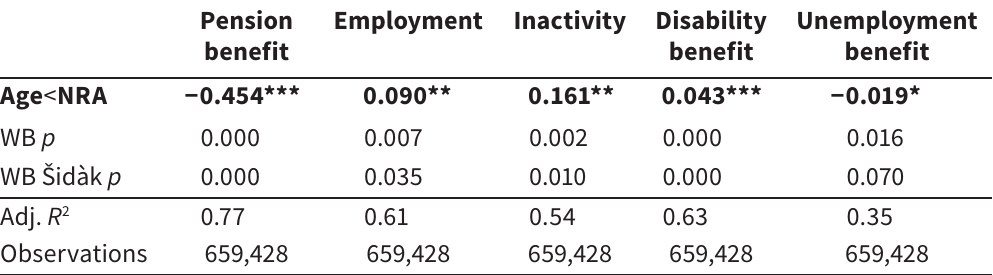
Table D2 Effect of raising the NRA: Eq. 2 excluding from controls time fixed effects Pension Employment benefit